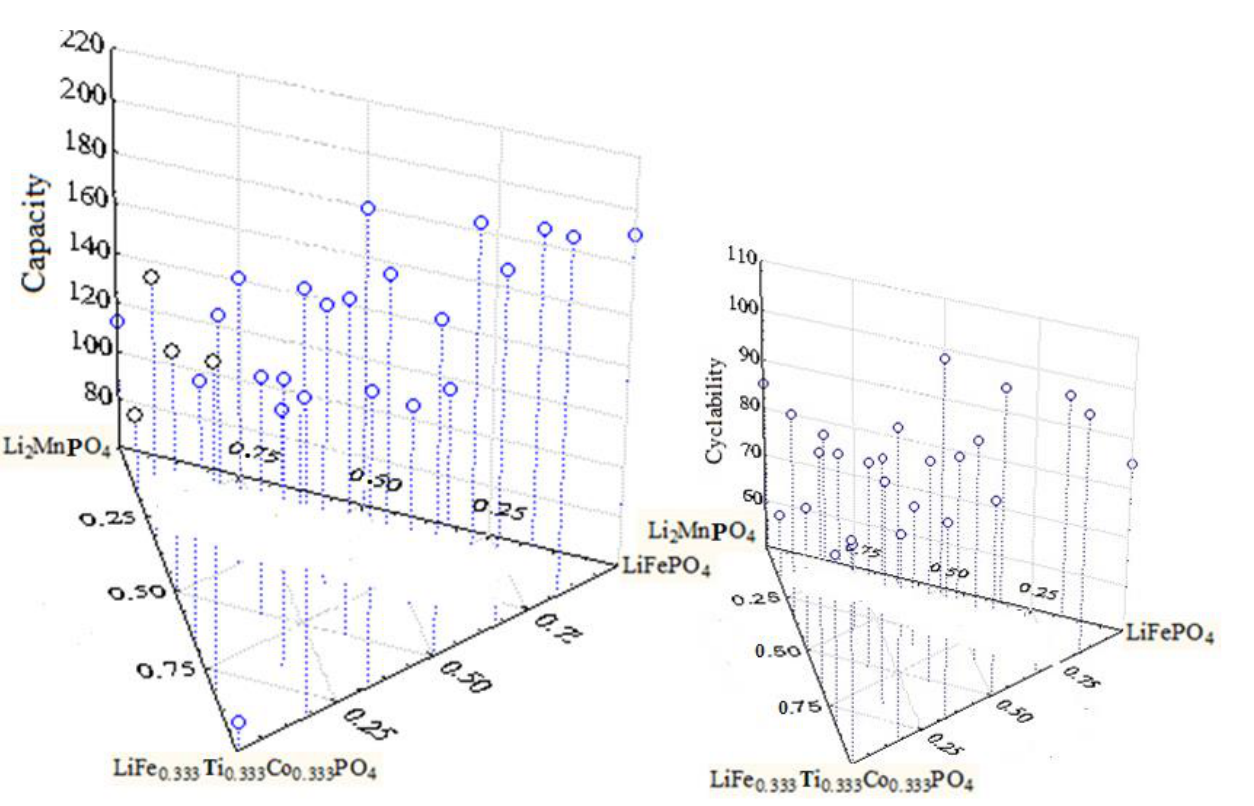
Figure 7. The capacity and cyclability versus composite systems including (1-x-y) LiFe 1/3 Ti 1/3 Co 1/3 PO 4 , xLi 2 MnPO 4 and yLiFePO 4. Although the structure of Li 2 MnO 3 or Li [Li 1/3 Mn 2/3 ] O 2 is similar to that of LiCoO 2 Table 4. Summary capacity and cyclability for 28 samples for the system (1-x-y)Fe 0.333 Ti 0.333 Co 0.333 PO 4 , xLi 2 MnPO 4 and yLiFePO4 composites.